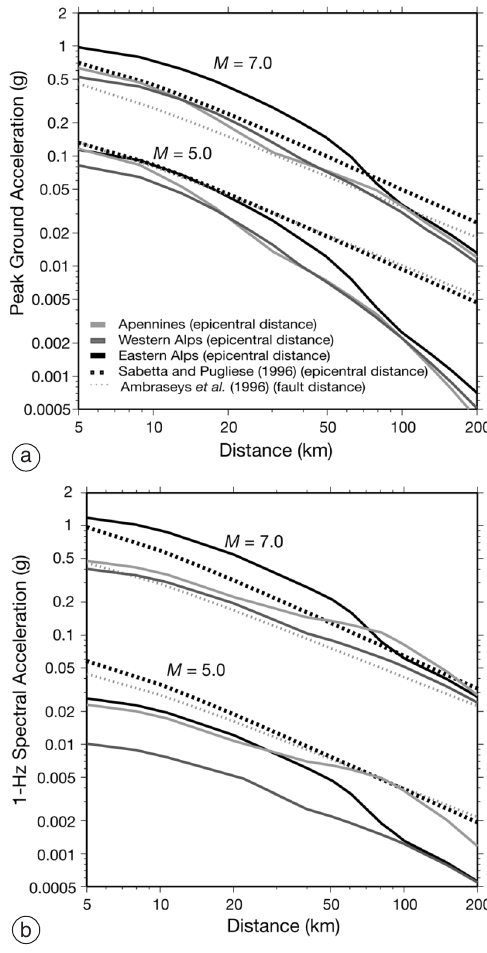
a Fig. 2a,b. Comparison between a) Peak Ground Ac- celeration (PGA) predicted by regional attenuation relationships (Malagnini et al. , 2000, 2002; Morasca et al. , 2004) for M = 5.0 and M = 7.0 (solid line) with the results of the empirical regressions by Ambraseys et al. (1996) (dotted curves) and Sabetta and Pugliese (1996) (dashed curves); b) 1-Hz Spectral Acceleration (SA).